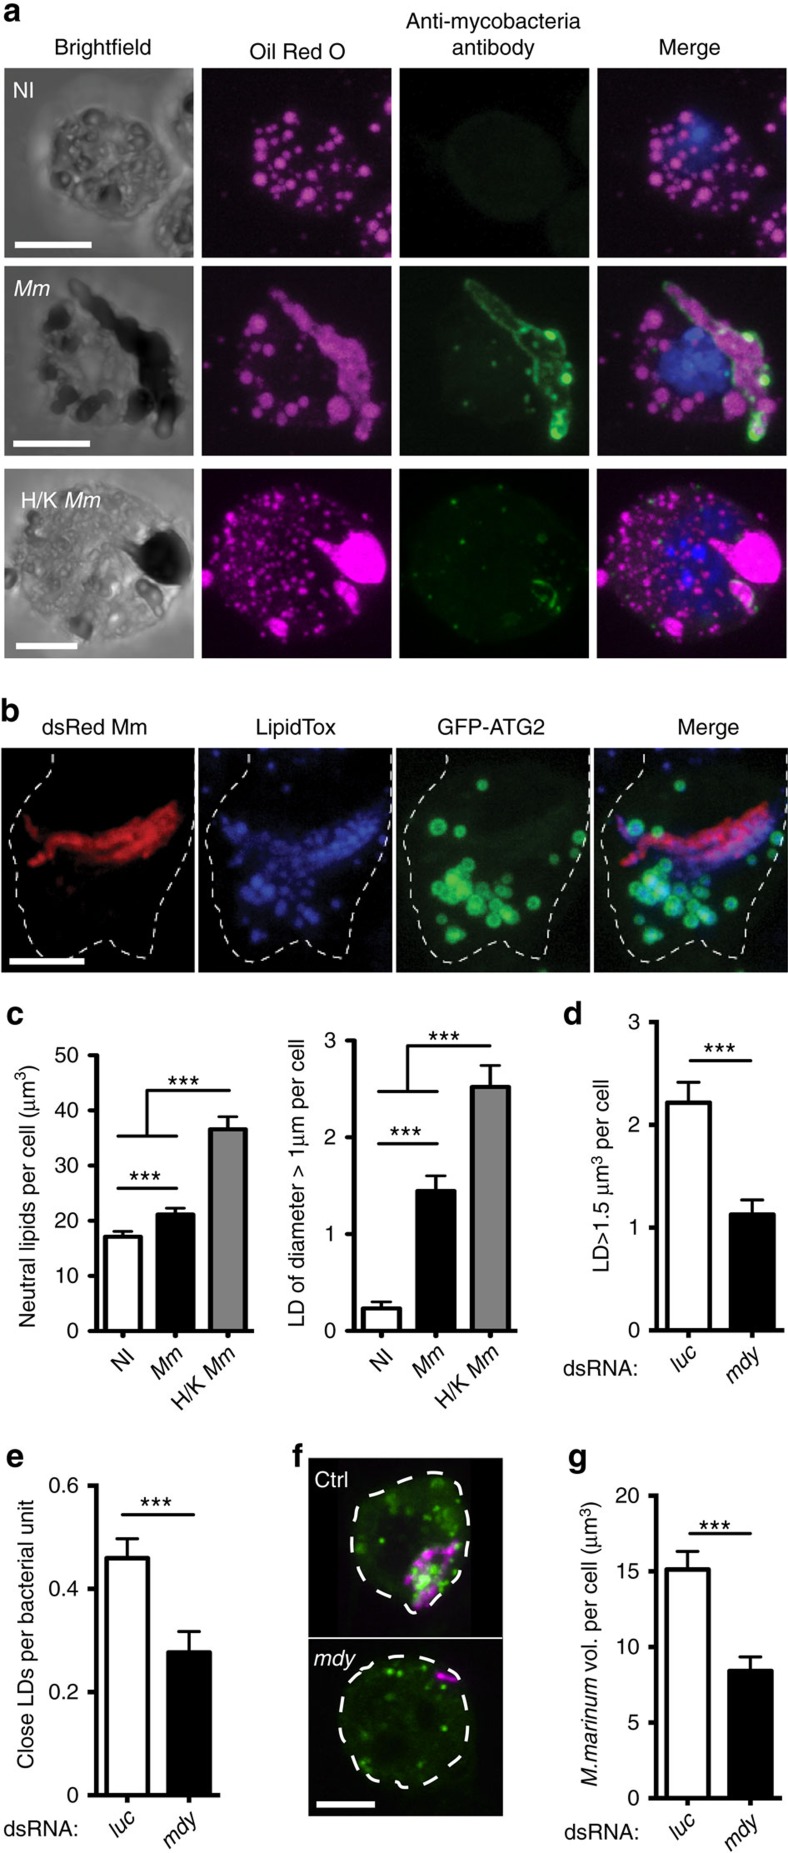
M. marinum driven lipid accumulation is required for intracellular growth or survival of mycobacteria.(a) Neutral lipids (stained with Oil Red O) and intracellular mycobacteria (stained with fluorescein isothiocyanate-anti-M tuberculosis) in cells variously uninfected, infected with live M. marinum or infected with heat-killed (H/K) M. marinum. (b) Co-localization of ATG2-GFP with LipidTox-stained intracellular neutral lipids. Cells were observed 48 h after transfection. Scale bars, 5 μm. (c) Quantification of neutral lipid volume per cell and total number of LDs with at least one axis >1 μm in length in cells treated as in b. Values are statistically different (**P<0.01 and ***P<0.001) by Mann–Whitney test. n=130 for non-infected cells, n=110 for M.m.-infected cells and n=96 for cells in contact with heat-killed M.m. (d) Number of LDs (stained with BODIPY 500/510) of volume ≥1.5 μm3 in cells treated with dsRNA for mdy or Luc, and infected with dsRed M. marinum. Values are statistically different (***P<0.001 by Mann–Whitney test, n=71 for mdy dsRNA, n=135 for Luc dsRNA). (e) Number of LDs (stained with BODIPY 500/510) at a distance ≤1 μm from bacteria and measured per unit of bacterial volume. Cells were treated with dsRNA for mdy or Luc and infected with dsRed M. marinum. Values are statistically different (***P<0.001 by Mann–Whitney test, n=64 for mdy dsRNA, n=119 for Luc dsRNA). (f) Co-localization of BODIPY-stained LDs with dsRed M. marinum in S2R+ cells with or without mdy knockdown. Scale bar, 5 μm. (g) Quantification of bacterial volume per cells in S2R+ cells treated with dsRNA for mdy or Luc and infected with dsRed M. marinum. Values are statistically different (***P<0.001 by Mann–Whitney test, n=64 for mdy dsRNA, n=119 for Luc dsRNA).